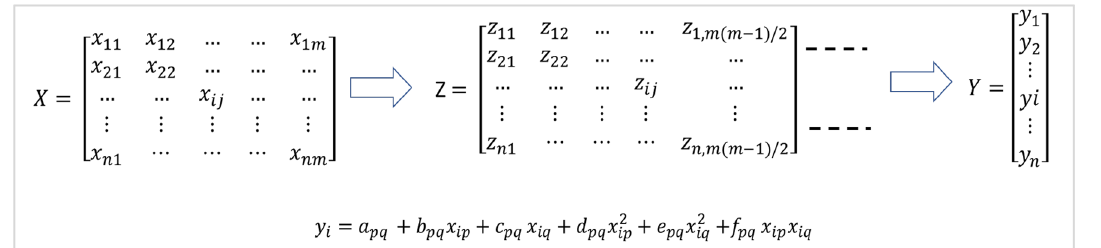
Fig. 13 GMDH method